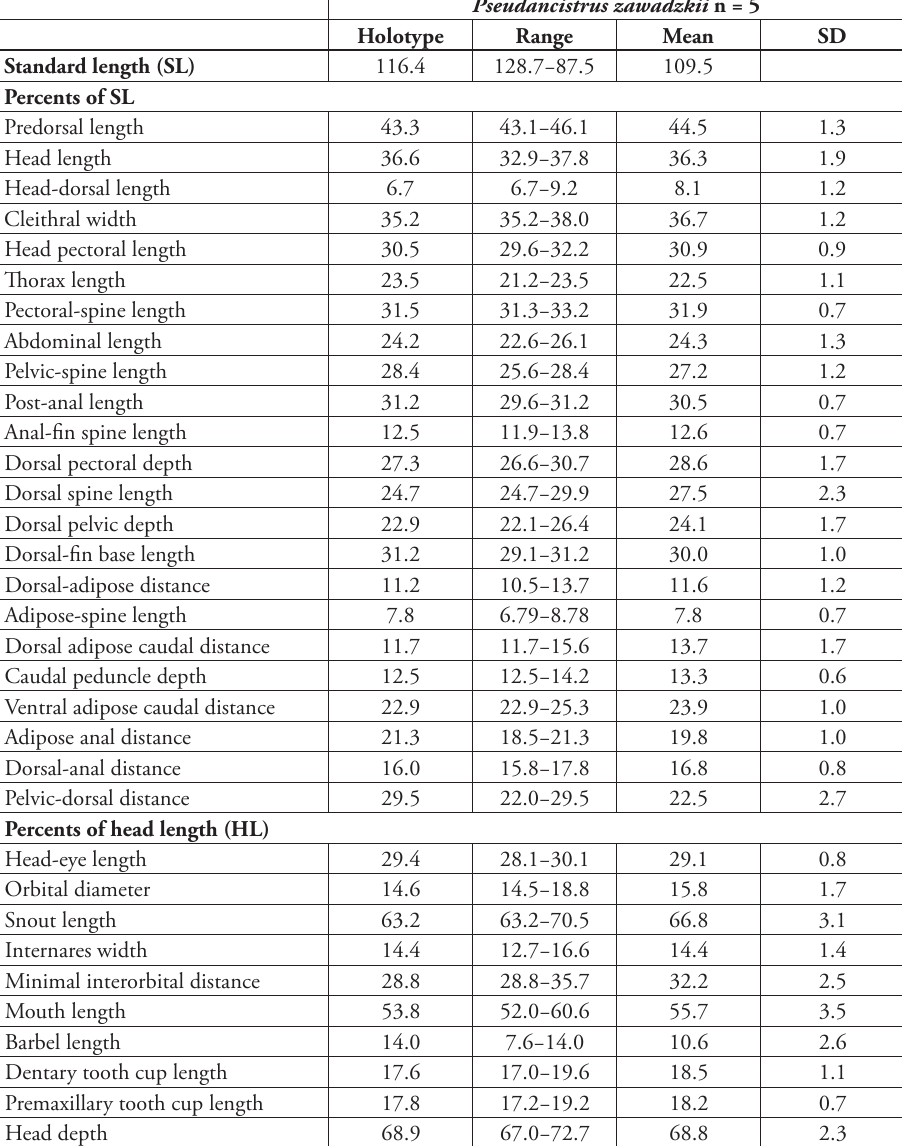
Table 1. Morphometric data for Pseudancistrus zawadzkii